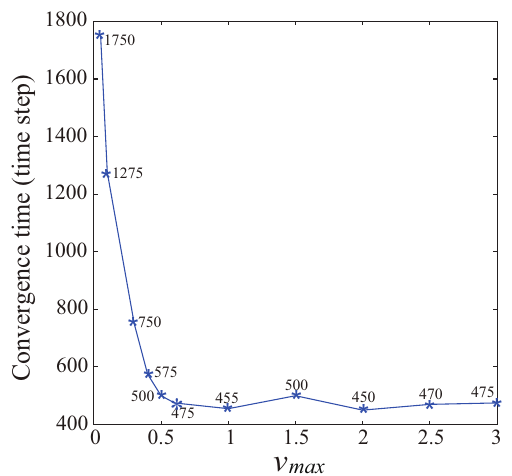
Figure 3. Variation of convergence time as a function of v max for the case of PCD = 0.4.